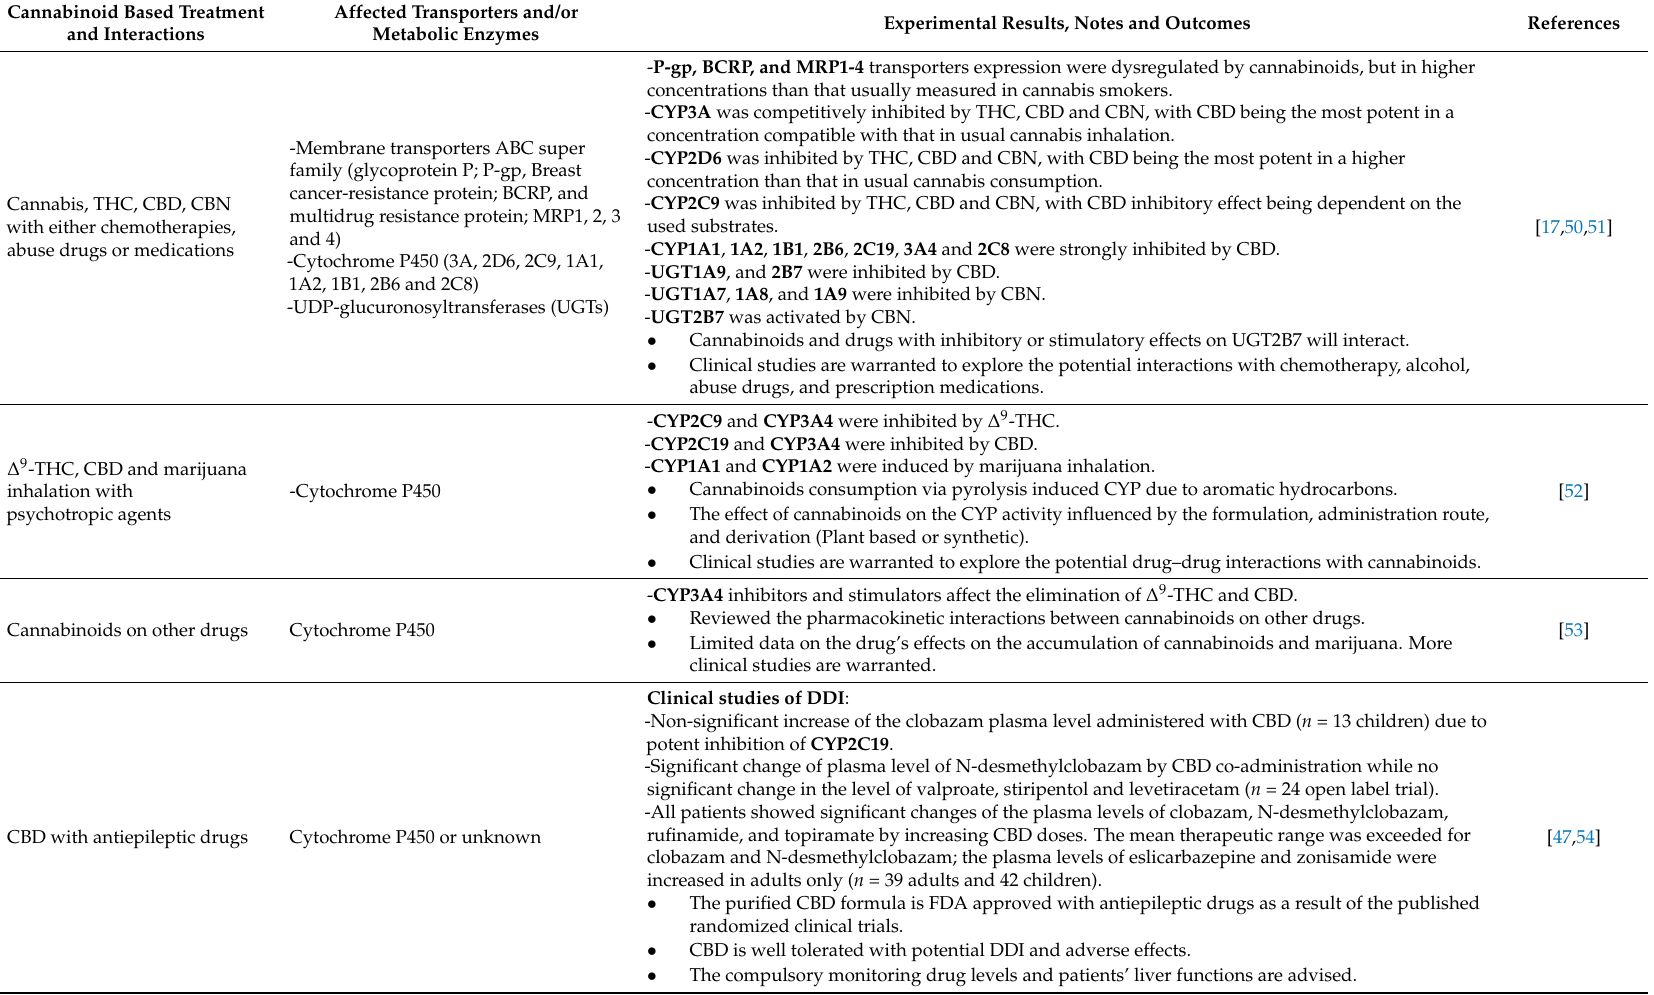
Table 2. Overview of the recent reviews of the drug–drug interactions with